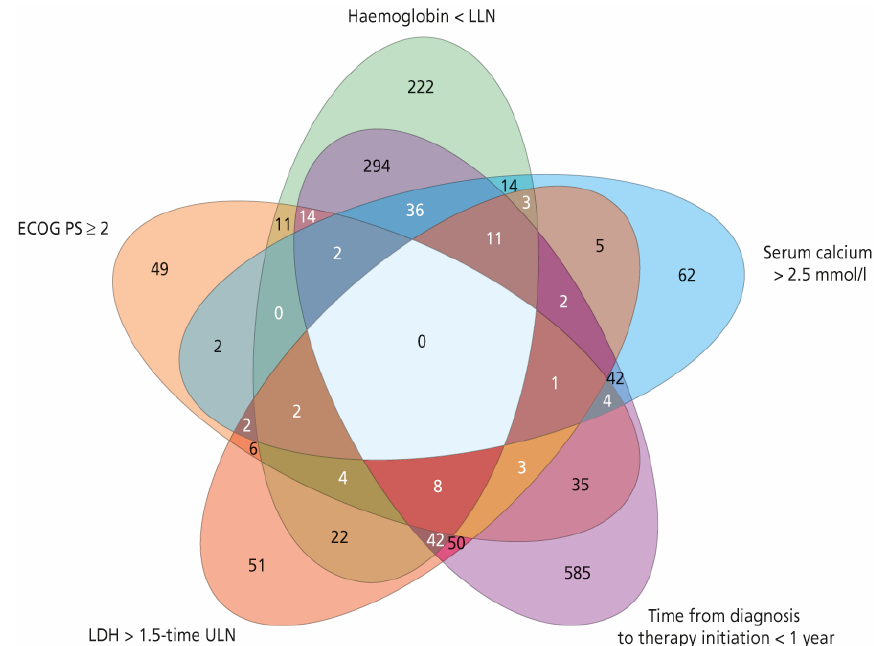
Figure 1. Frequency diagram of each combination of risk factors for the Memorial Sloan–Kettering Cancer Center (MSKCC) score. ECOG PS = Eastern Cooperative Oncology Group performance status, LLN = lower limit of normal, ULN = upper limit of normal, LDH = lactate dehydrogenase.